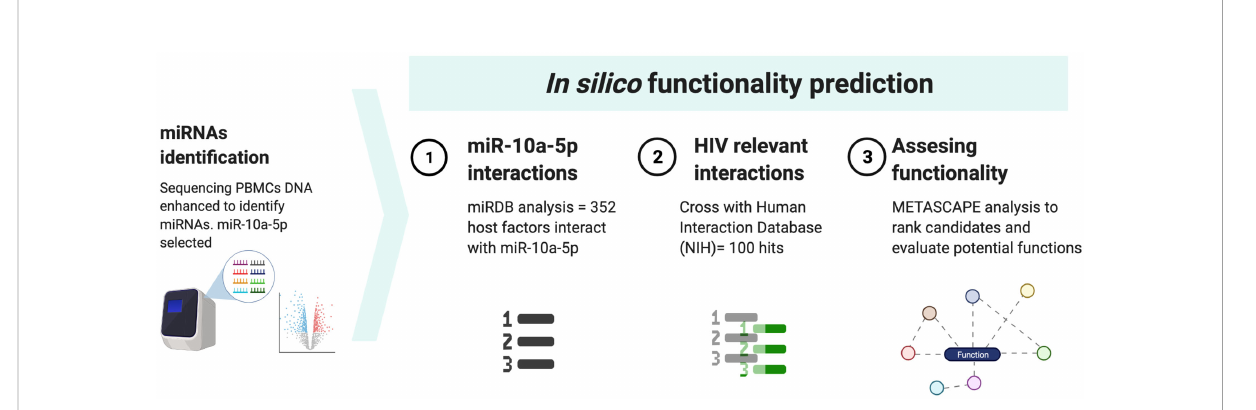
FIGURE 1 Work fl ow for in silico prediction of